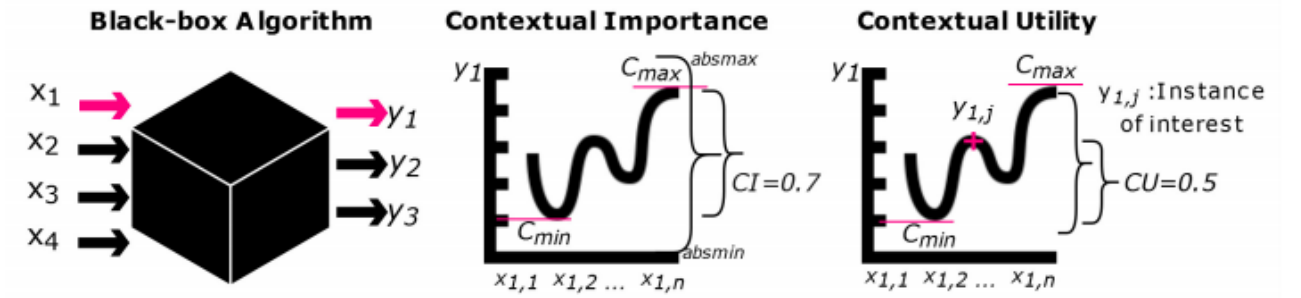
Figure 5. CIU explainable method